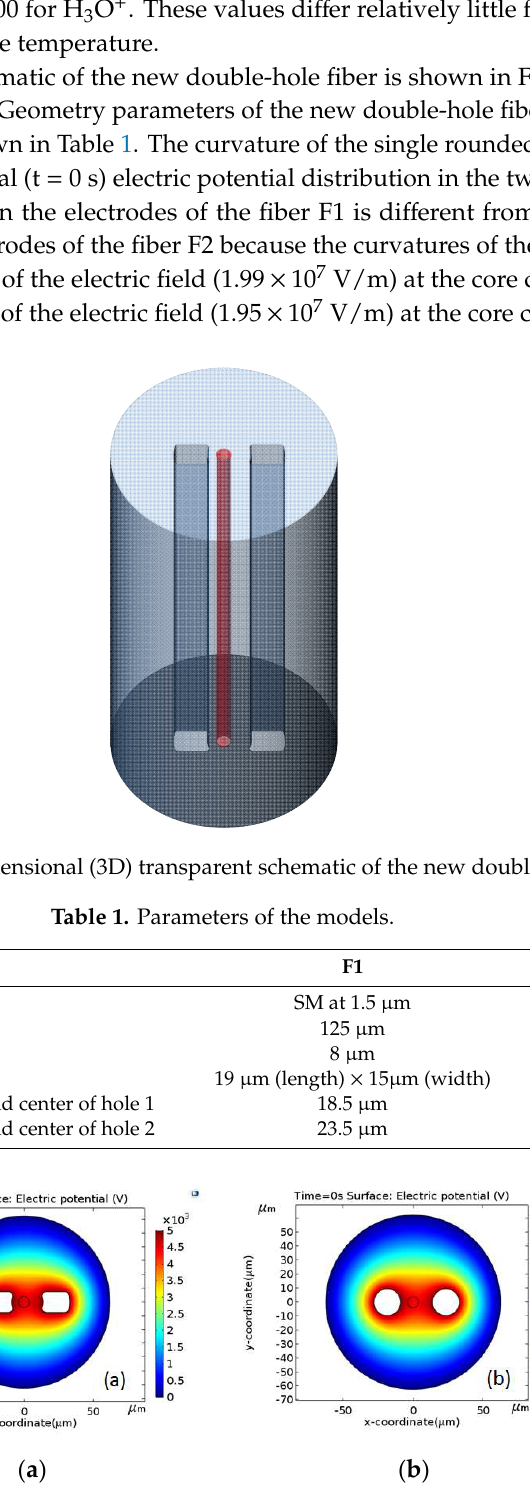
Figure 2. Map of the initial (t = 0 s) electric potential across the fibers F1 ( a ) and F2 ( b ).